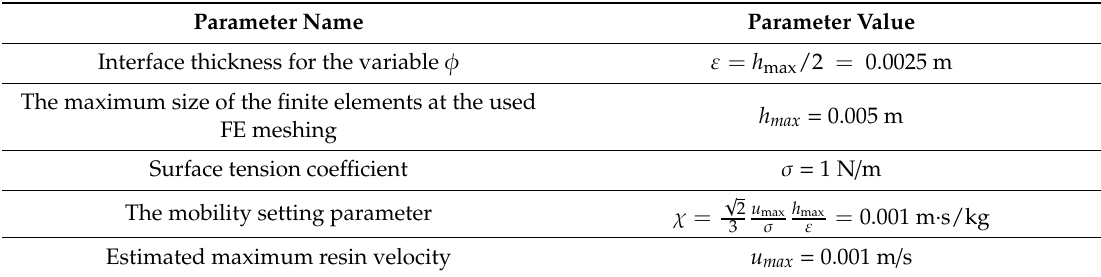
Table 2. The values of the phase field equation’s parameters, which were accepted at the finite element (FE) model